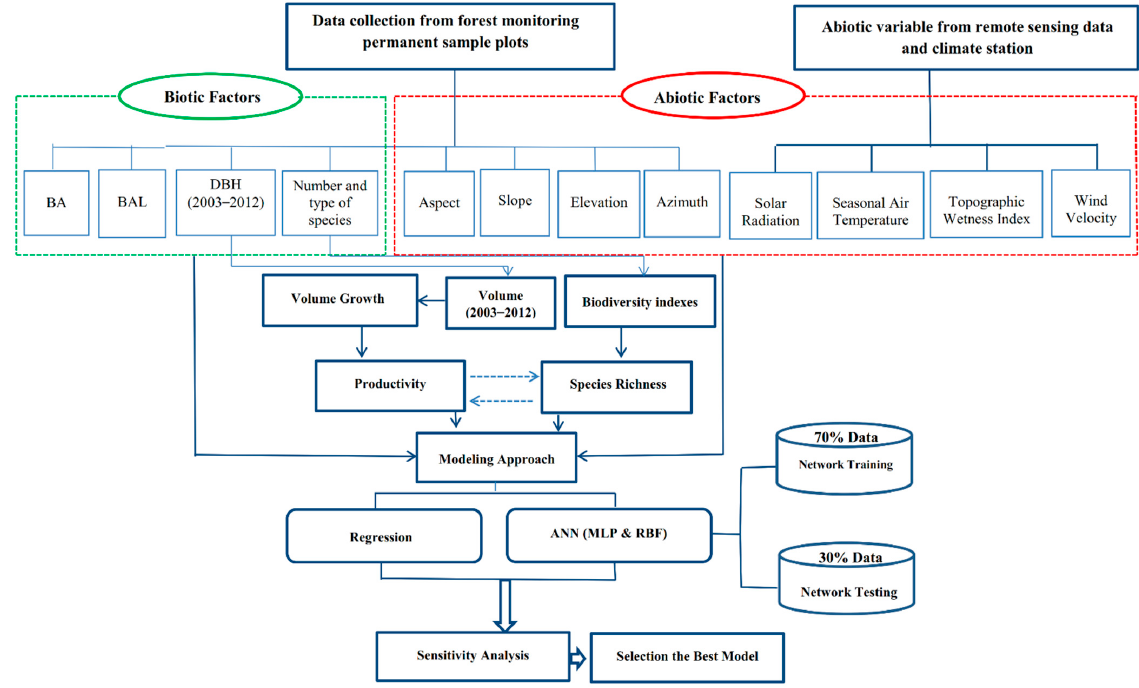
Figure 2. A flowchart representing significant stages of the research.